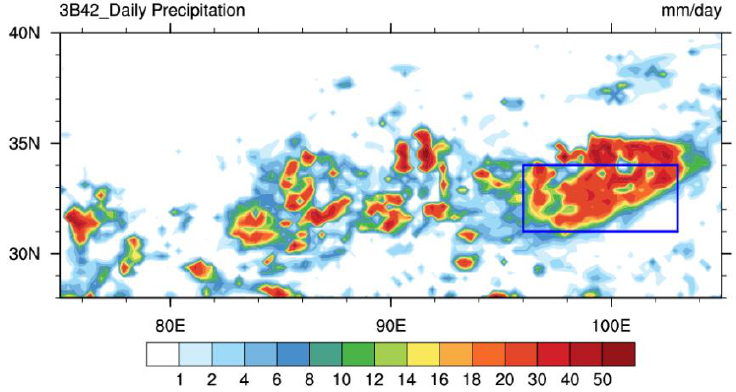
Figure 1. Spatial distribution of the daily aggregated precipitation (units: mm/day) over the Tibetan Plateau (28°N–40°N, 75°E–105°E) on 5 August 2014. The blue box is the precipitation area detected by TRMM PR.